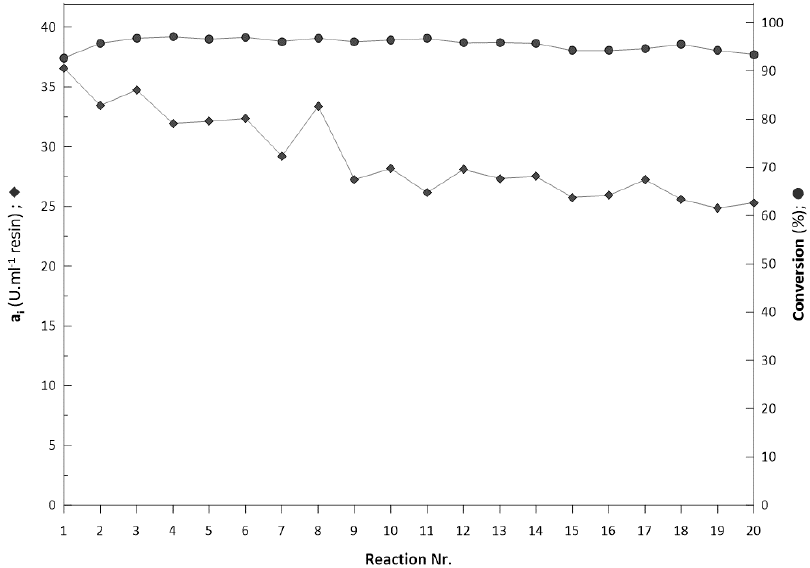
Figure 10. Repeated biotransformation with substrate concentration of 130 mM.